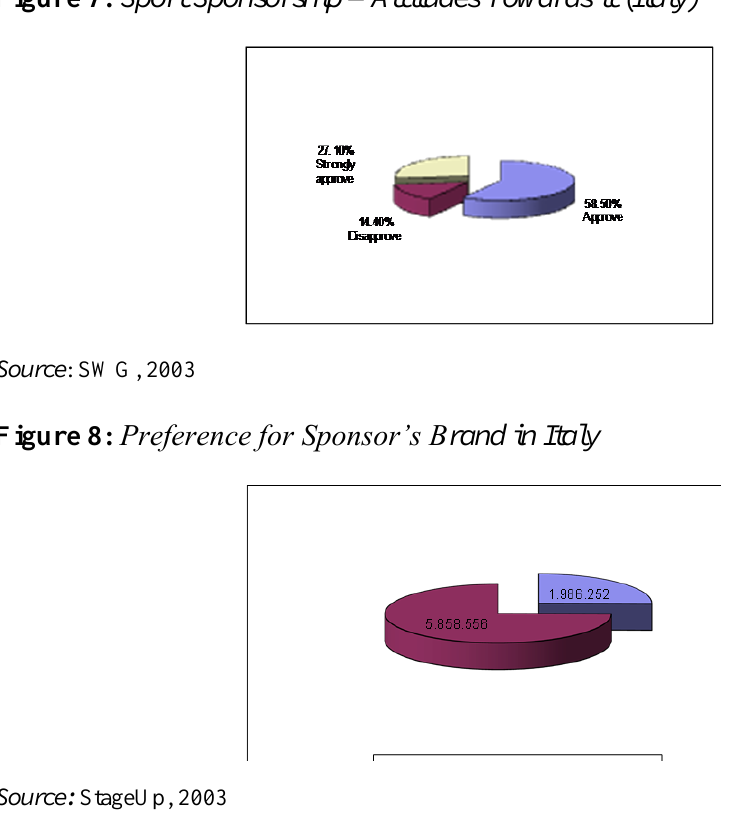
Figure 7: Sport Sponsorship – Attitudes Towards it (Italy)